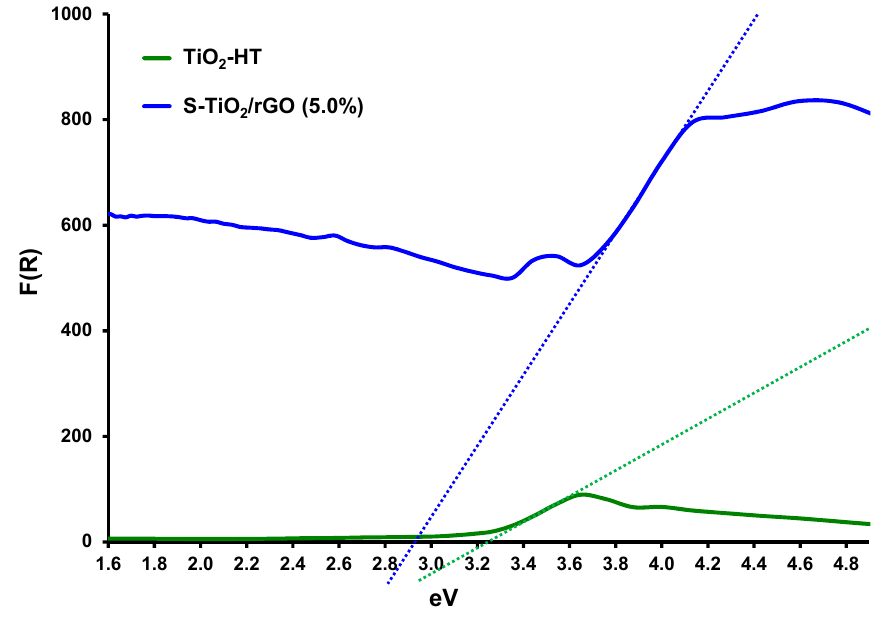
Figure 7. Diffuse reflectance spectra (DRS) spectrum of TiO 2 [34] and S-TiO 2 /rGO(5.0%). Figure 7. Di ff use reflectance spectra (DRS) spectrum of TiO 2 [34] and S-TiO 2 /